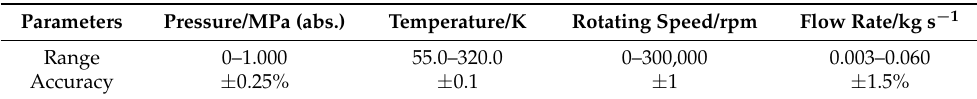
Figure 2. Schematic view of the turbo-based air refrigerator. Table 1. Measure parameters.